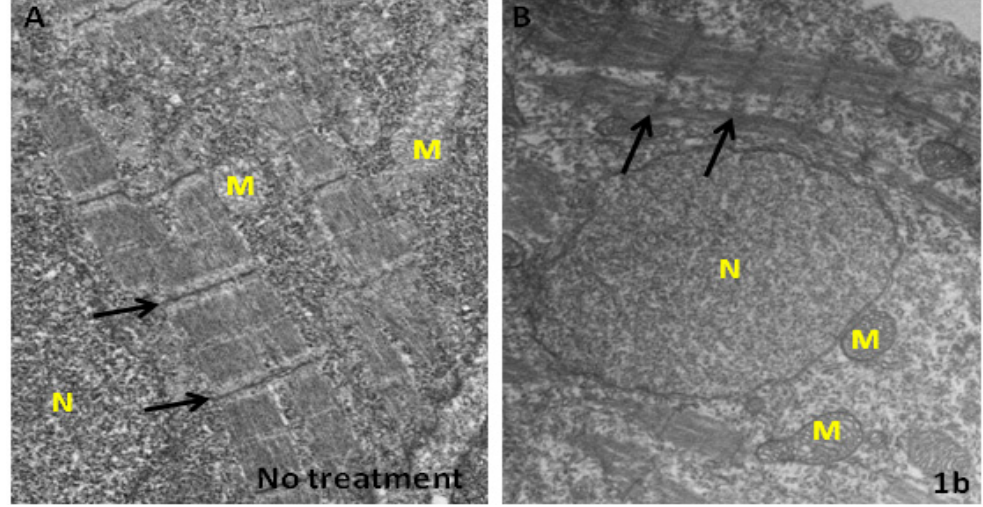
Figure 5. Compound 1b affects ultrastructure of myofibril. Representative images of TEM of zebrafish embryo after exposure to water ( A ) or water containing 3 ppm of compound 1b . ( B ) Arrows indicate the positions of Z-line. M: mitochondria; N: